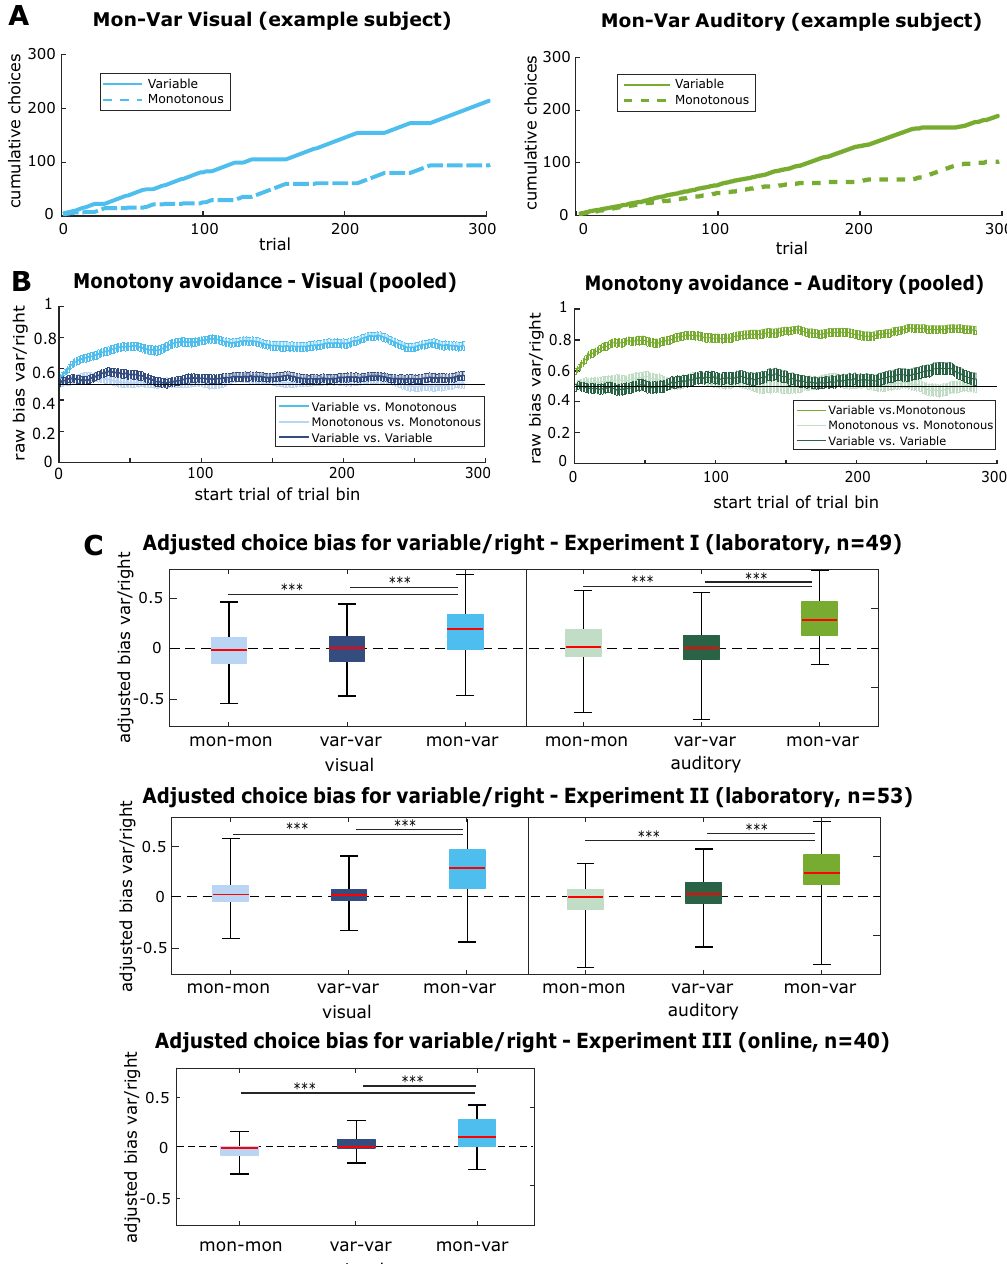
Figure 2. Boredom bias of monotony avoidance in the Boredom Choice Task: ( A ) Choice behavior of one exemplary subject in the visual and auditory monotonous vs. variable ( Mon–Var ) BCT cycle. The cumulative number of choices for either alternative is plotted over the respective trial. ( B ) Average raw boredom bias of all participants from Experiment Ia-c (n = 142 participants for visual modality, n = 102 participants for auditory modality) over the duration of each task cycle across all conditions. The raw boredom bias is computed in a bin of 15 trials (first bin: trial 1–15) which is then shifted stepwise until the end of the task (last bin: trial 286–300). The vertical bars indicate the standard error of the mean. ( C ) Boxplots with the distributions of the adjusted boredom bias for Experiment Ia (n = 49 participants), Ib (n = 53 participants) and Ic (n = 40 participants). The red line indicates the median, the box indicates the upper and lower 25% quantiles and the whiskers indicate the 50% quantiles around the median. Blue colors reflect visual task cycles, whereas green colors represent auditory task cycles. In all experiments the Mon–Var distributions were significantly different from a mean of zero (***p < 0.001 in one-sample t